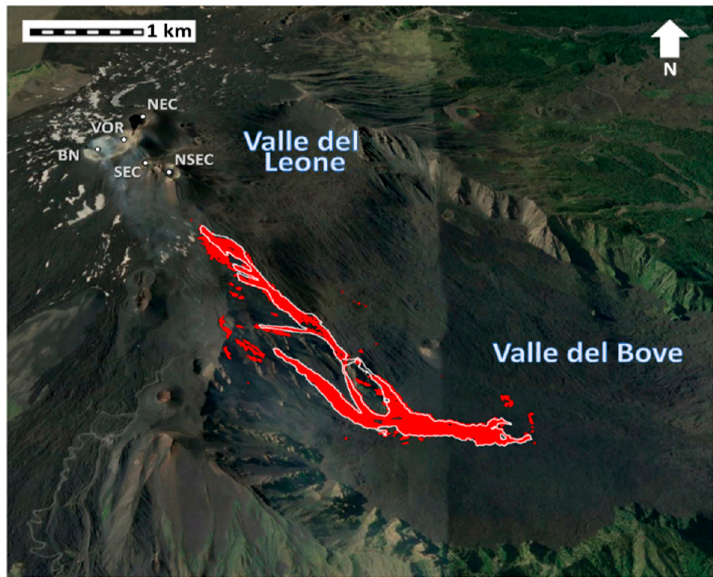
Figure 7. Lava flow map resulting from the BNN and the post-processing stages (red) and the contour of the real lava flow (white) observed during the Etna eruption that occurred in December 2018.